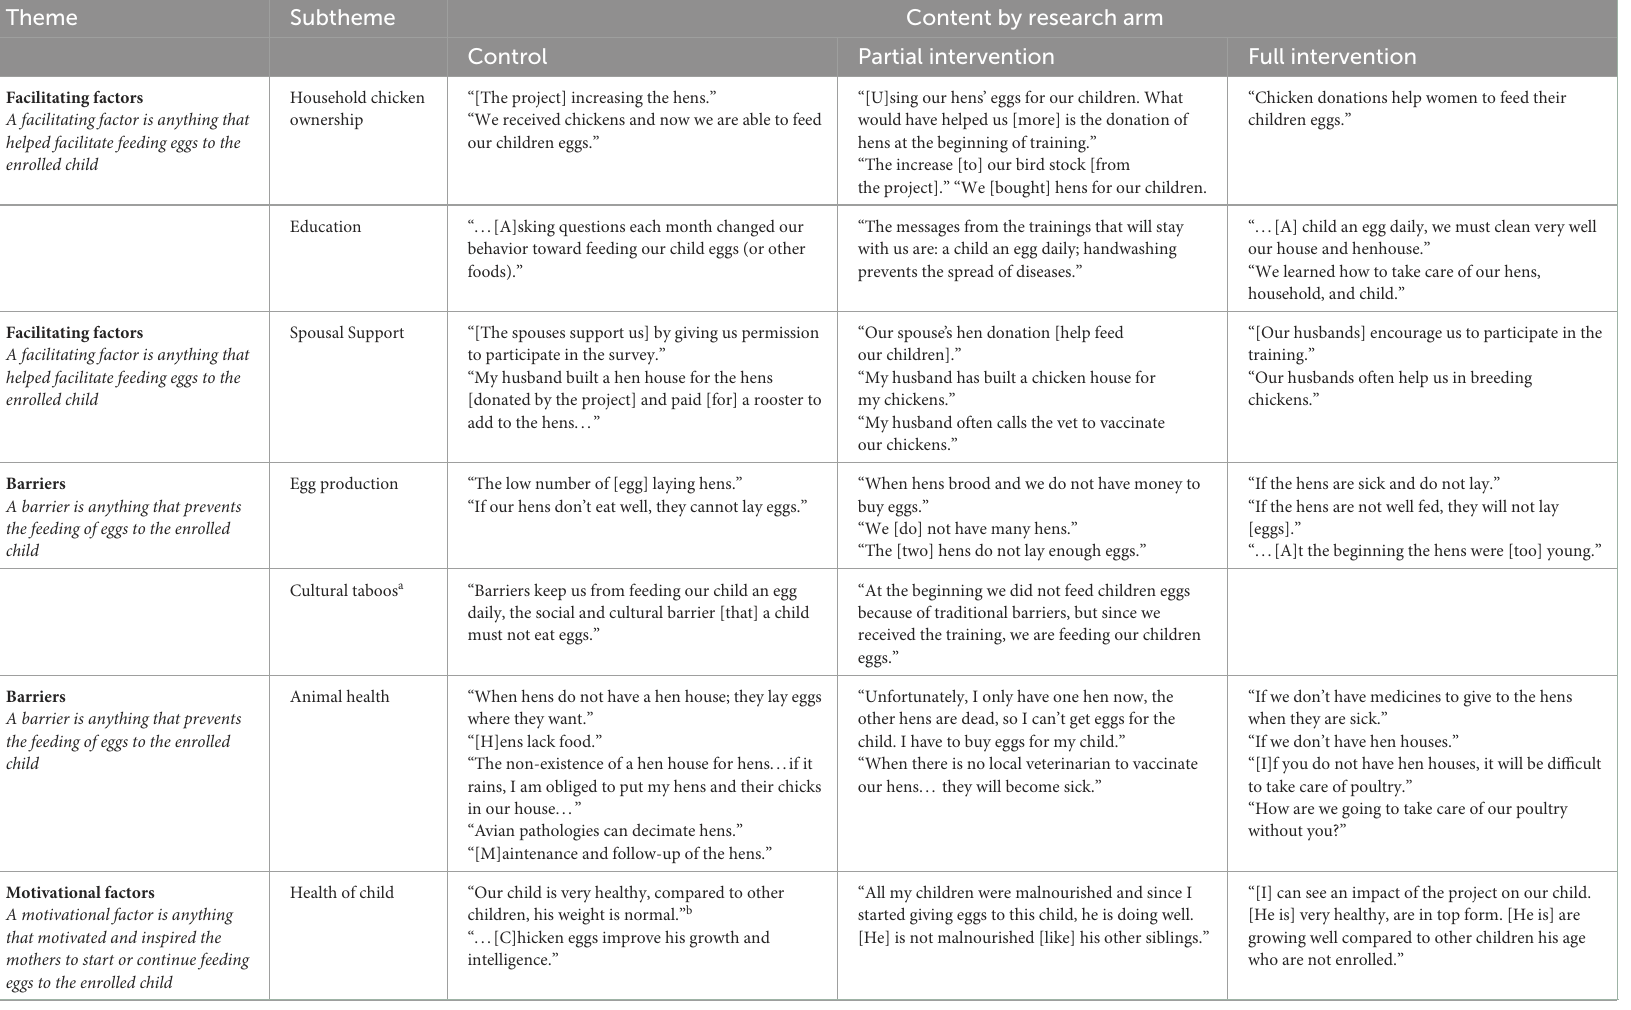
TABLE 2 Taxonomy of themes and subthemes from focus group discussions with the Un Oeuf study participants by research arm.